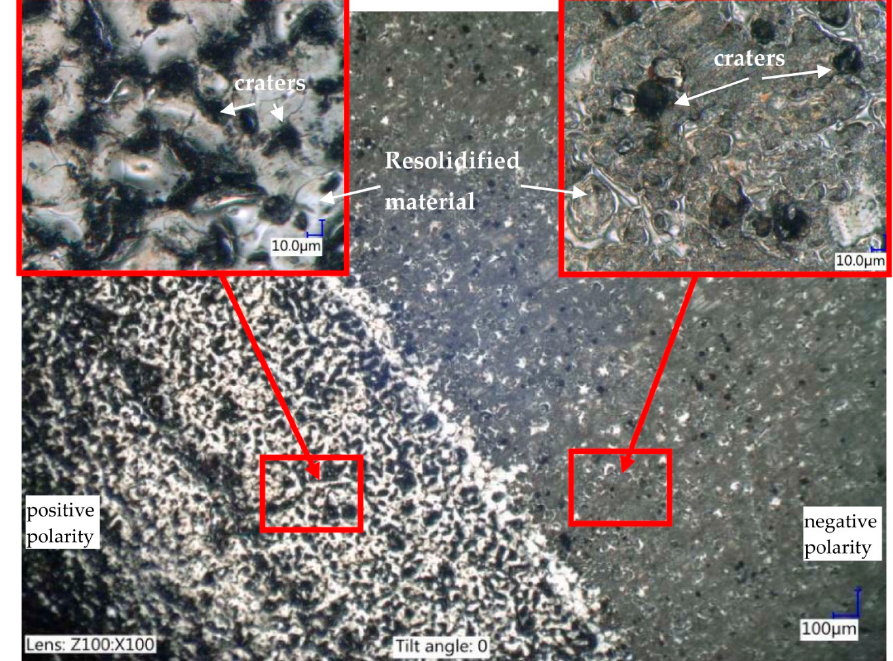
Figure 5. The surface texture of the tool steel 55NiCrMoV7 after PMEDM in the dielectric with 2% RGO, positive polarity, and negative polarity; manufacturing time = 60 s.